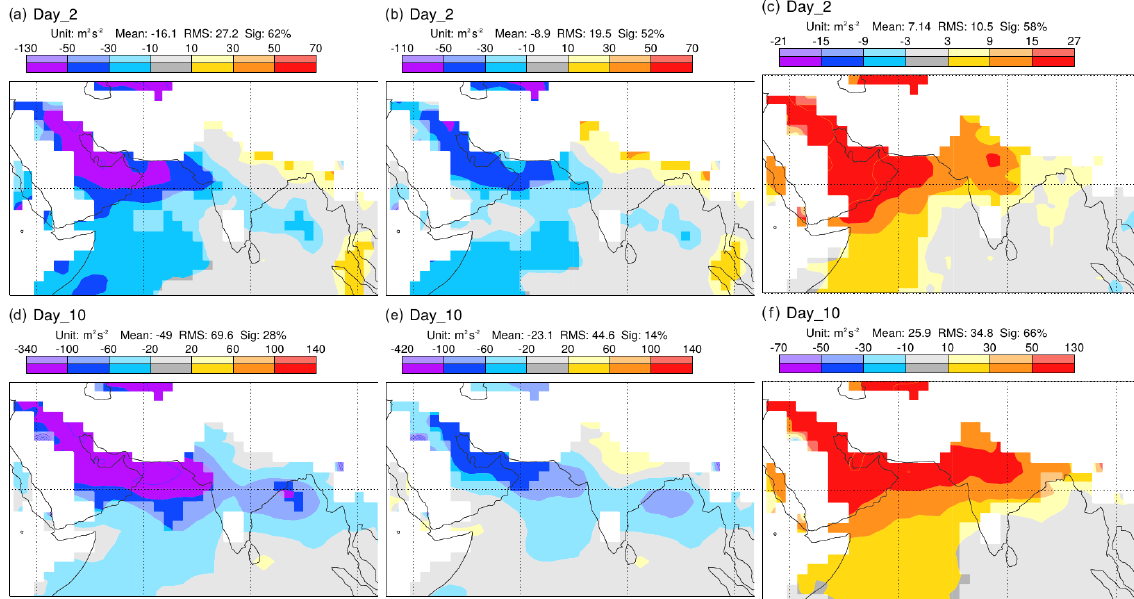
Figure 13. As Fig. 12 but for the geopotential at 925hPa (in metres squared per second squared).